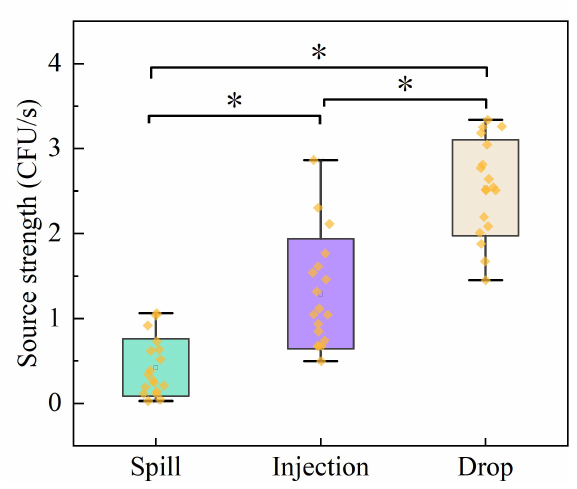
Figure 5. Aerosol release source intensity. * p < 0.05, Statistical significance between source intensity of three risk factors, ns is no statistical difference. (Wilcoxon Paired Sign Rank Test).